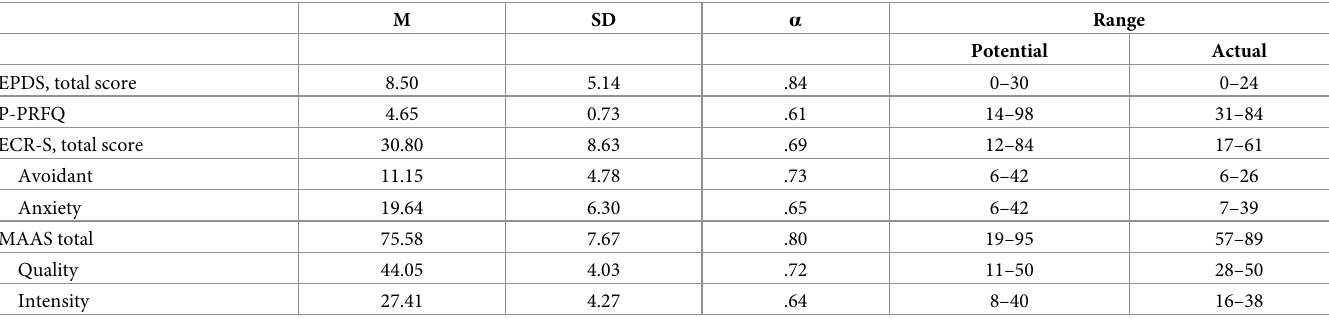
Table 2. Descriptive statistics for prenatal maternal